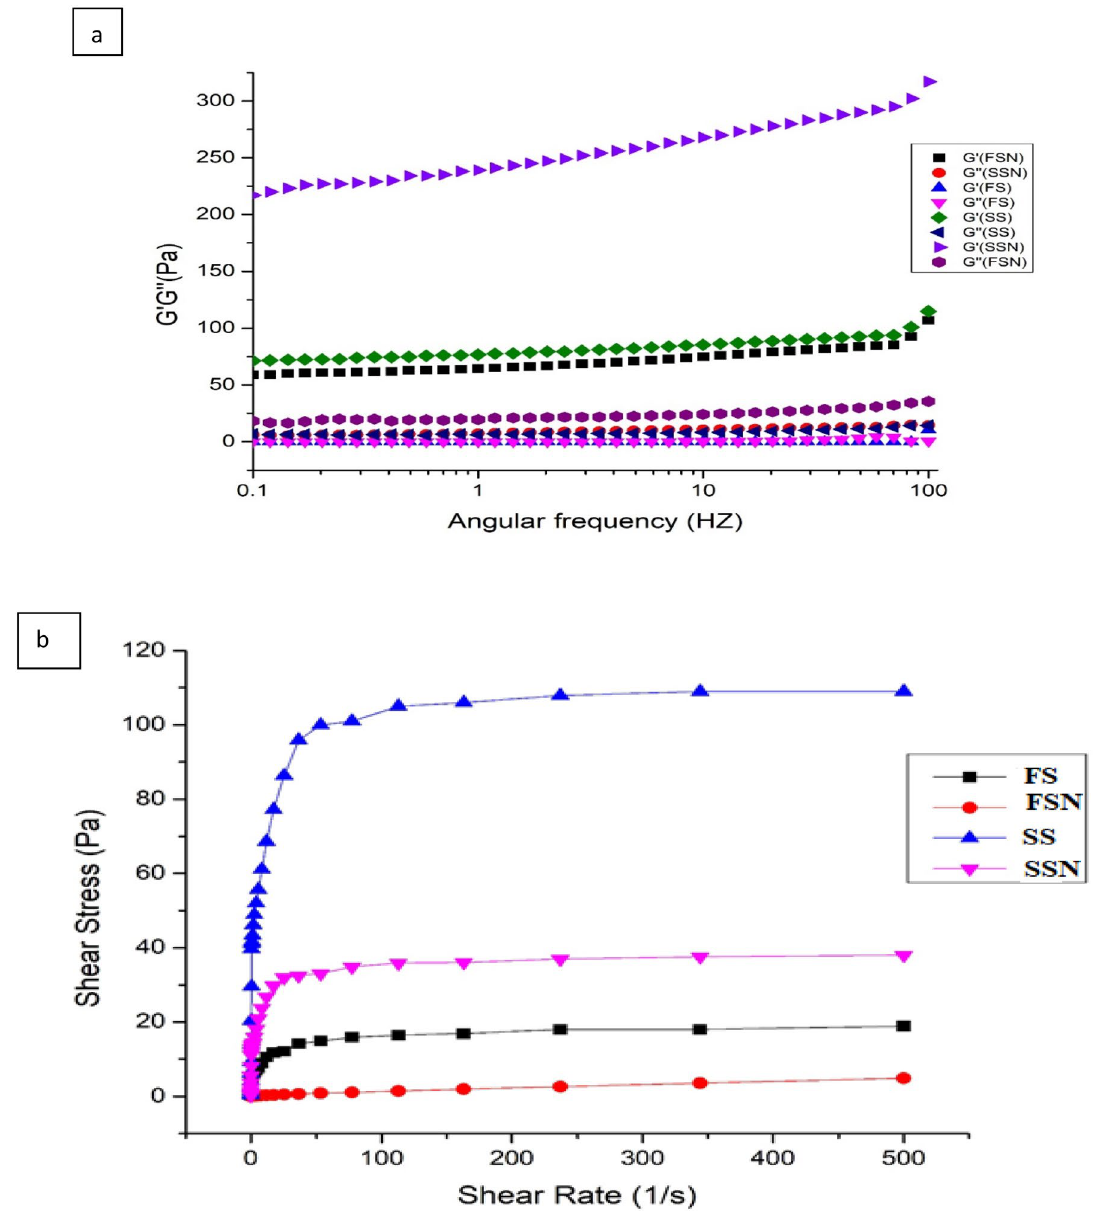
Figure 5. (a,b) Mechanical spectra measured as function of storage modulus (G´) and loss modulus (G´´) of starch samples (a) Flow curves of native and nano starch pastes (b) . FS, FSN, SS and SSN represents native foxtail millet starch, nano foxtail millet starch, native sorghum starch and nano sorghum starch,